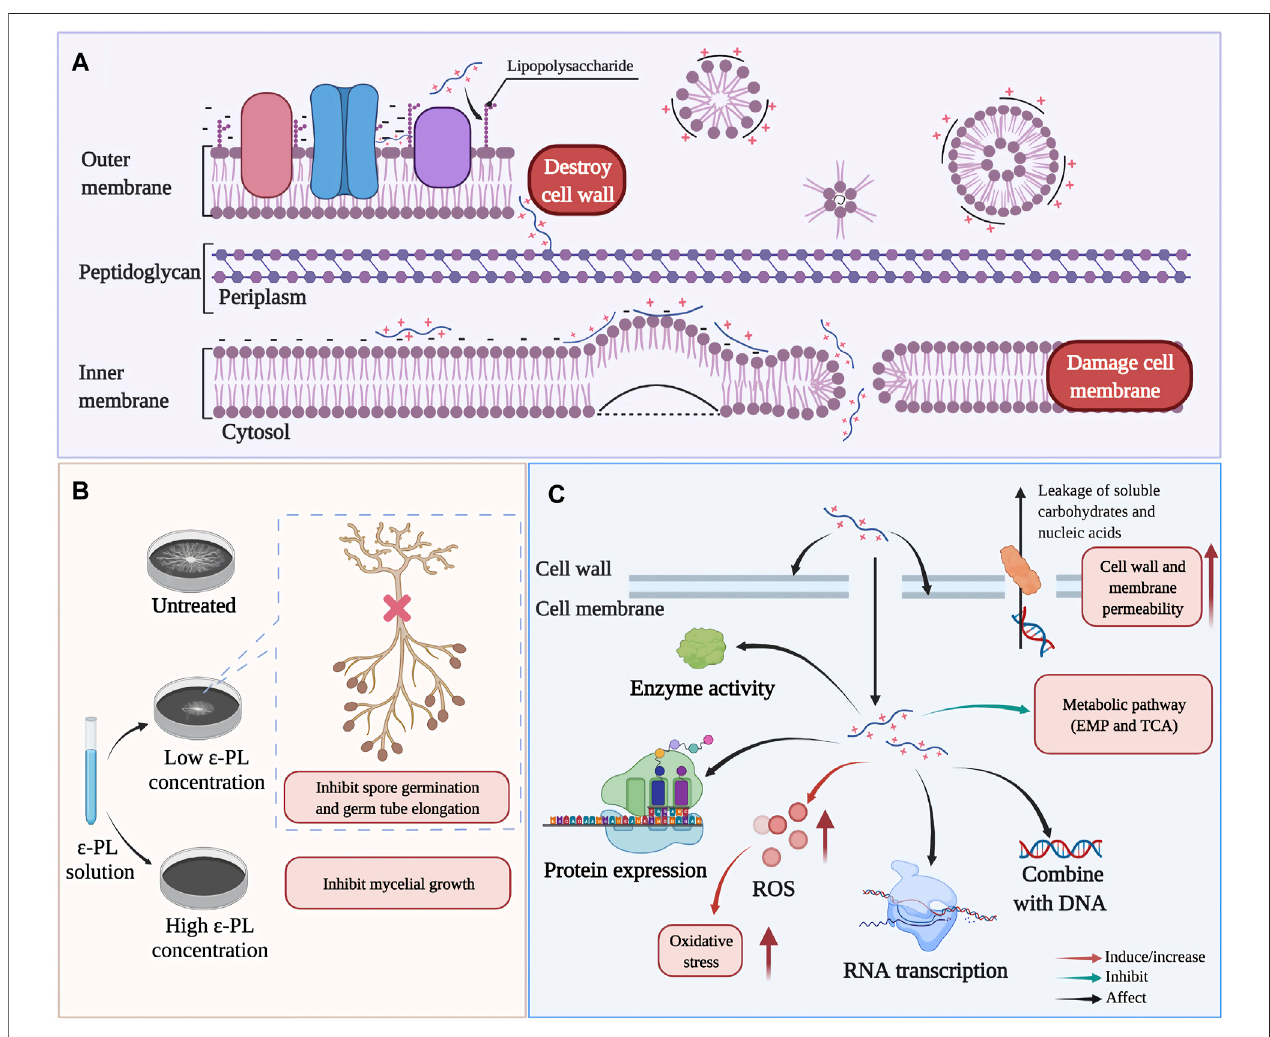
FIGURE 6 | Possible antimicrobial mechanisms of ε -PL. (A) the action of ε -PL on cell structure of Escherichia coli O157:H7 (Ye et al., 2013). (B) The inhibition of ε -PL on spore germination and germ tube elongation (Liu Z. et al., 2020). (C) Summary of main antibacterial actions of ε -PL on different microorganism, such as E.coli, Shewanella putrefaciens,Staphylococcusaureus,Saccharomycescerevisiae,SalmonellaTyphimurium (Yeetal.,2013;Tanetal.,2019;Houetal.,2020;Shenetal.,2020;Houetal.,2021).